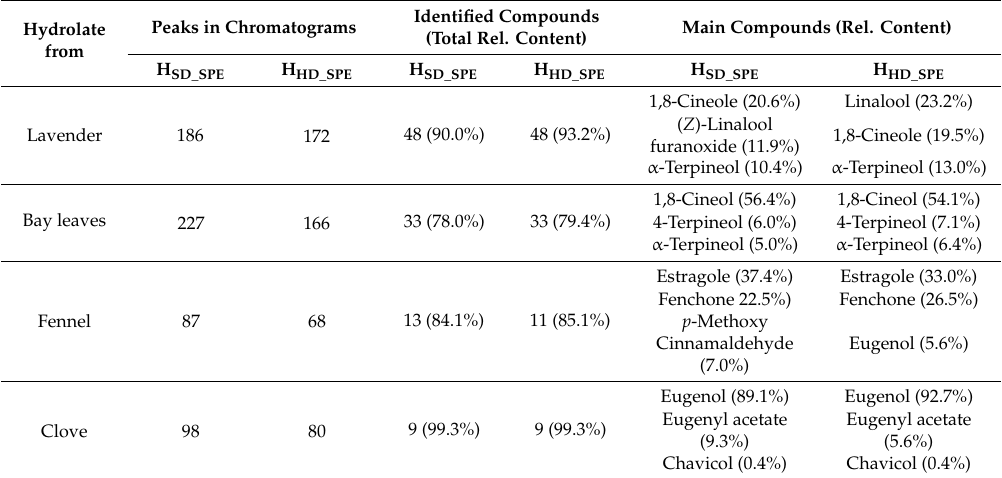
Table 1. Comparison of analyses of H SD_SPE and H HD_SPE extracts by means of peaks in chromatograms, identified compounds and three major components, n =